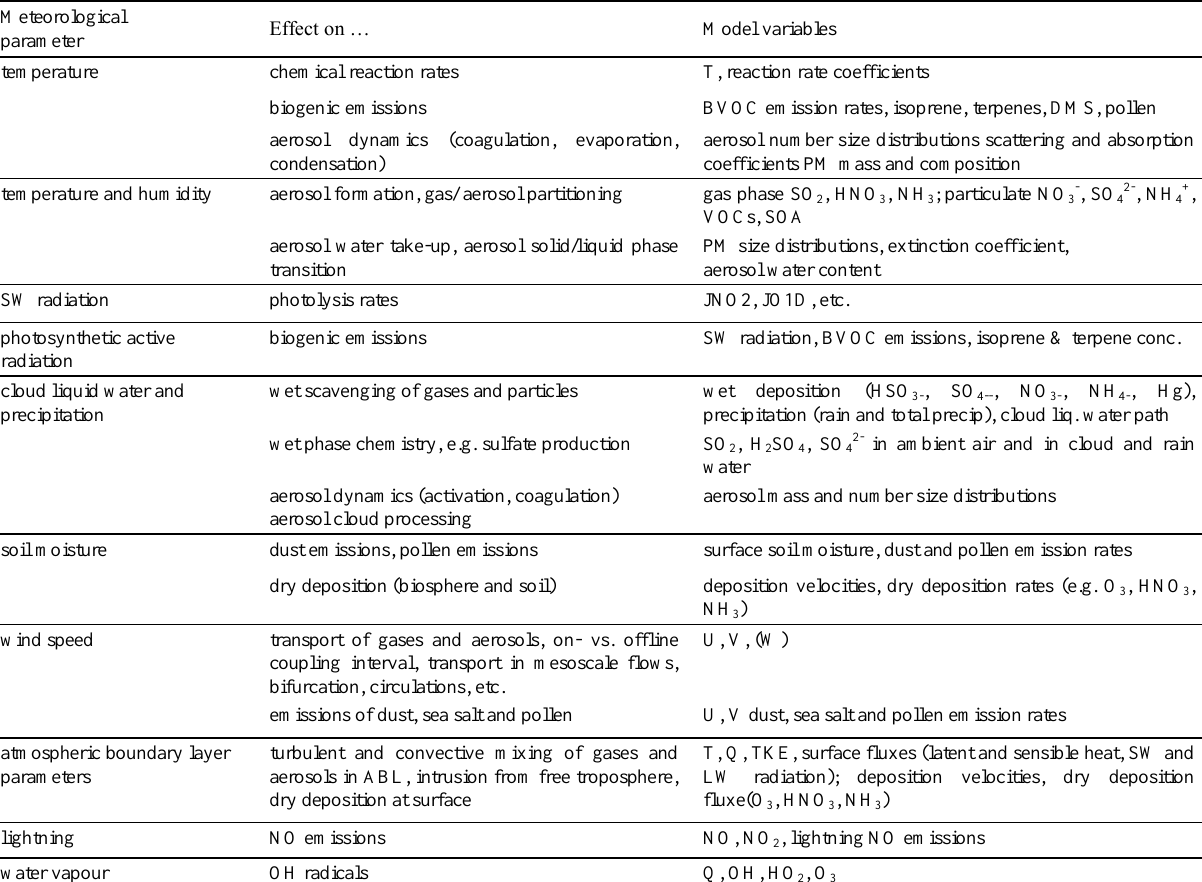
Table B1. List of effects of meteorology on chemistry.